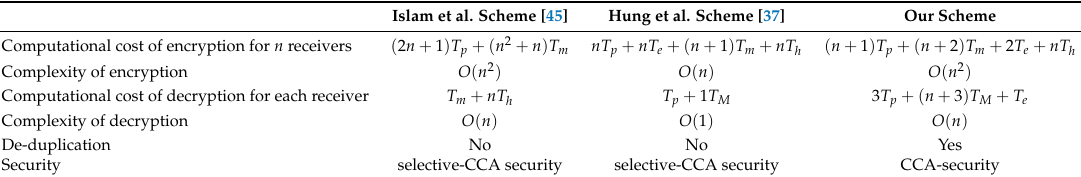
Table 1. Comparison of computation costs in the three